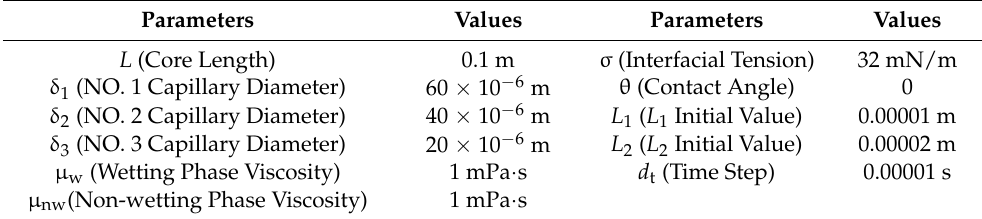
Table 1. Basic parameters of the three interaction capillary models.